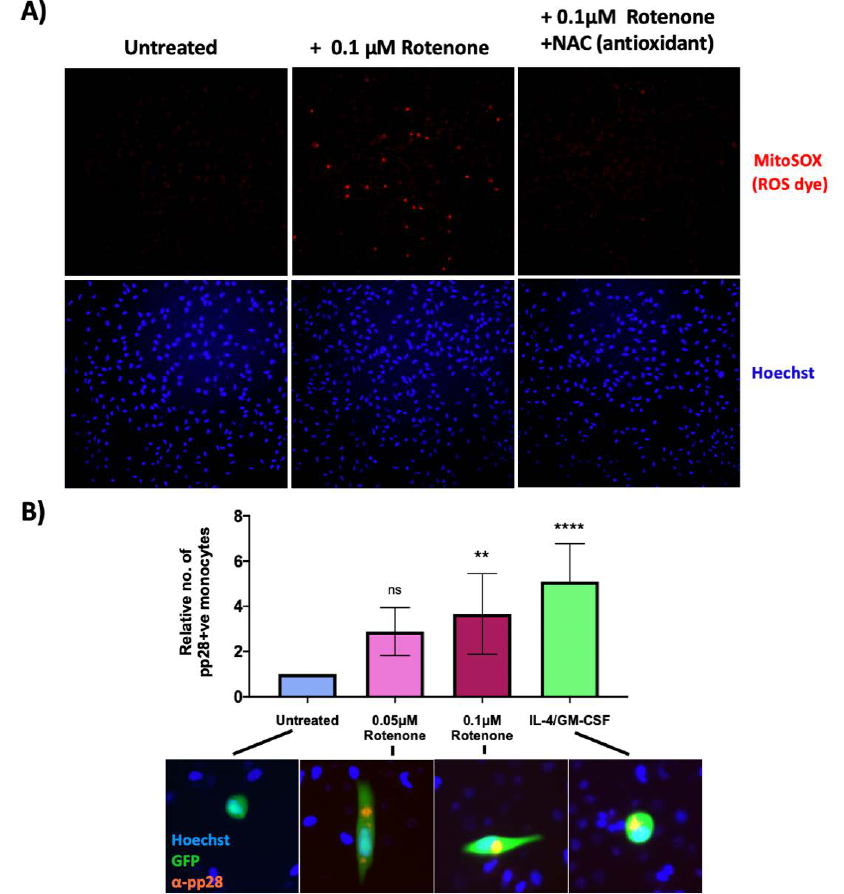
Figure 5. Low levels of rotenone induce superoxide formation in monocytes and prevent the establishment of HCMV latency. ( A ) CD14+ monocytes were treated with 0.1 μM rotenone or 0.1 μM rotenone with 1 mM NAC (antioxidant). 4 h post treatment, cells were stained with the superoxide dye, MitoSOX and visualised by fluorescence microscopy using a 10x lens. ( B ) CD14+ monocytes were infected with WT TB40E SV40-GFP virus at an MOI of 5. At 3 h.p.i, CD14+ cells were left untreated, treated with IL4/GM-CSF + LPS as a positive control for reactivation, or treated with two different concentrations of rotenone (0.05 μM or 0.1 μM). 7 d.p.i, cells were fixed and stained for the late lytic protein, pp28 as a marker of lytic infection. The graph shows the mean relative number of pp28-positive monocytes in each condition over 3 biological repeats. Error bars represent standard deviation. Significant increases relative to ‘untreated’ cells were determined using a nested one-way ANOVA with Dunnett’s post hoc testing. ns = not significant, ** = p < 0.01. **** = p < 0.0001. Merged colour channel images (20x) for each condition were produced on ImageJ. We then infected monocytes with TB40E SV40-GFP WT HCMV, and at 3 h.p.i, either left them untreated, treated them with two different concentrations of rotenone, or treated the cells with IL-4 and GM-CSF; IL-4/GM-CSF which differentiates the cells and acts as a positive control (since differentiated monocytes support a lytic infection). 7 d.p.i, cells were stained for the lytic protein, pp28. After treatment with rotenone,